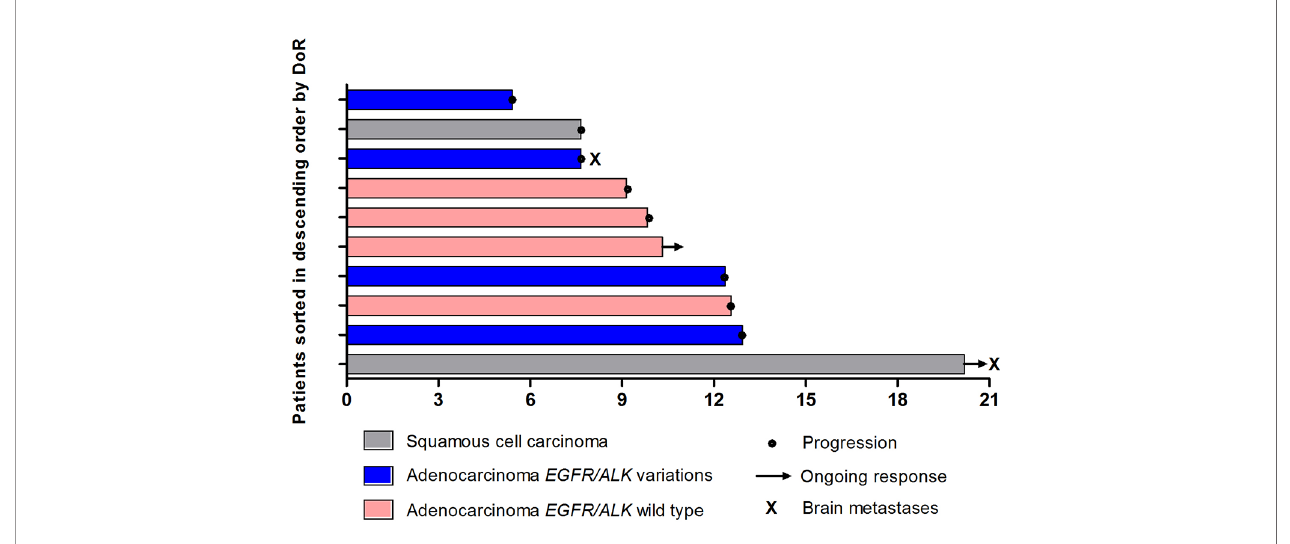
FIGURE 3 | Duration of response (DoR) (n =